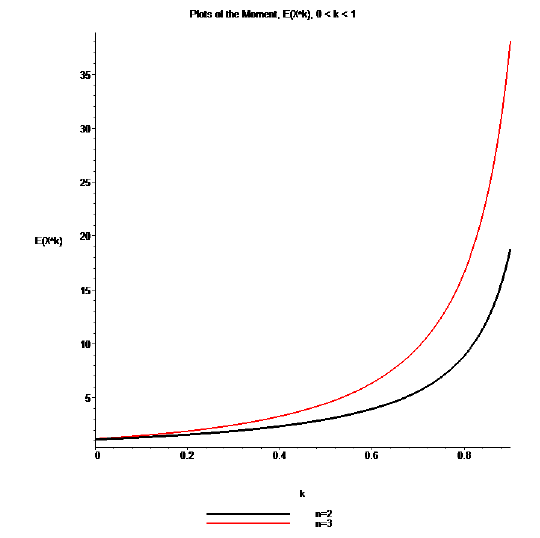
√ 2 ≤ x ≤ 1000 and n = 3 ,